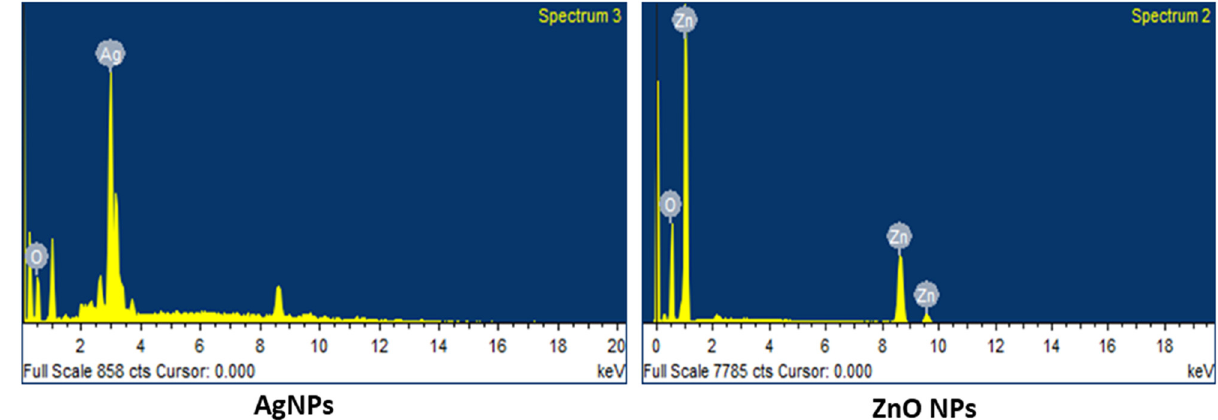
Figure 7: EDX analysis of Ag and ZnO - NPs.